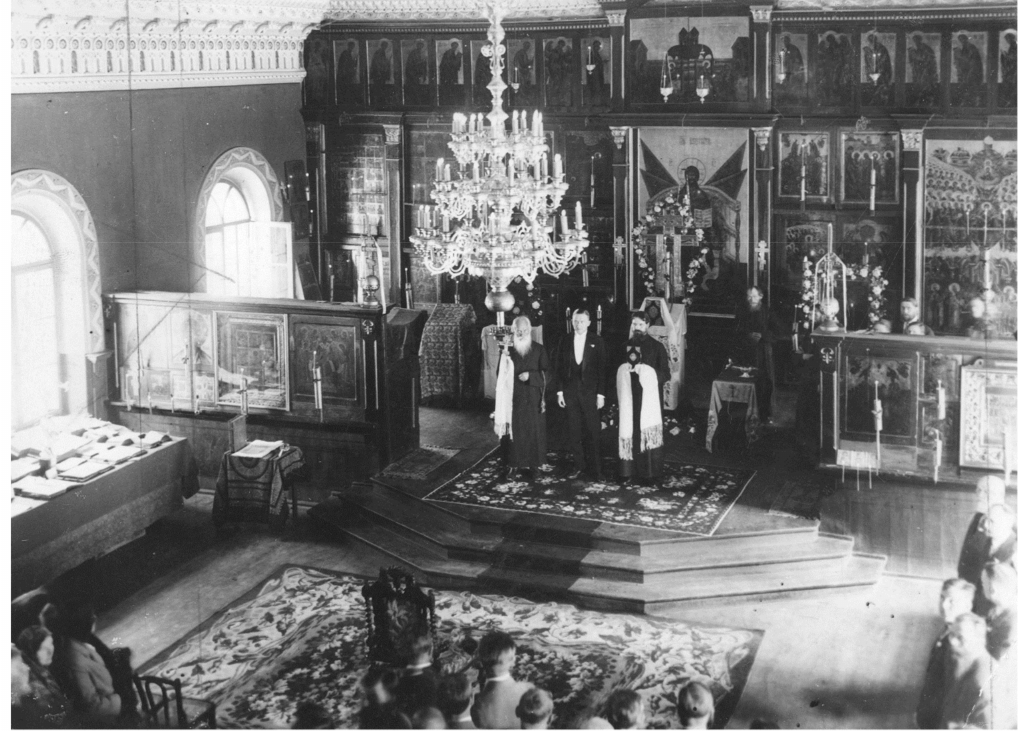
Figure 1. Molenna of priestless Old Believers in Vilnius (waiting for President Ignacy Mo´scicki), 1930, Warsaw, National Digital